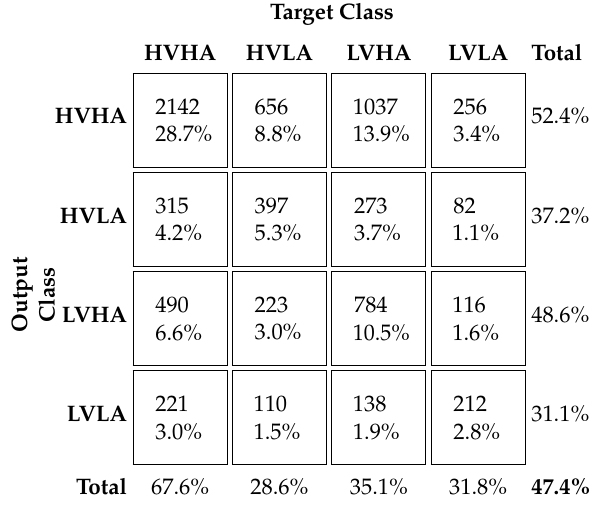
Table 9. Confusion matrix of EEG of DREAMER dataset.